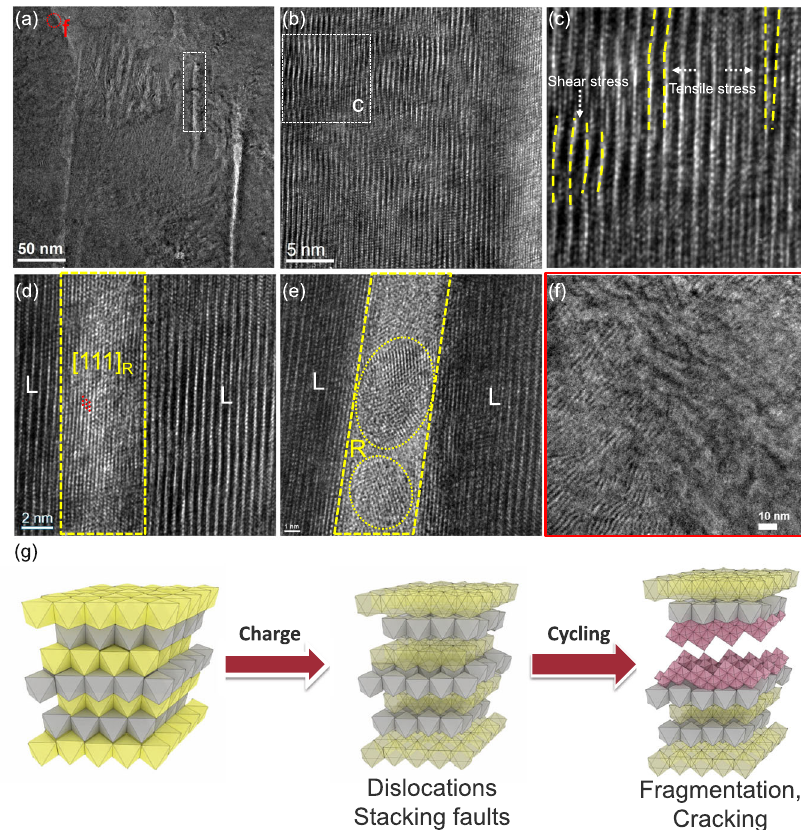
Fig. 5 TEM characterization on cycled O3 NaNi 0.4 Mn 0.4 Co 0.2 O 2 cathode particle (2.0 – 4.4 V for 100 cycles). a Low and b high magni fi cation TEM image. c Zoomed-in view of the dashed square area in b . d , e Zoomed-in views of the dashed rectangle area in a . f Zoomed-in view of dot-circle area in a . g Schematic illustration of the structural earthquake during cycling of strained O3 NaNi 0.4 Mn 0.4 Co 0.2 O 2 cathode. R and L in d , e represents rock-salt and layered structure, respectively. Yellow and gray octahedra represents NaO 6 and TMO 6 of a layered structure, respectively. Purple octahedra means rock- salt